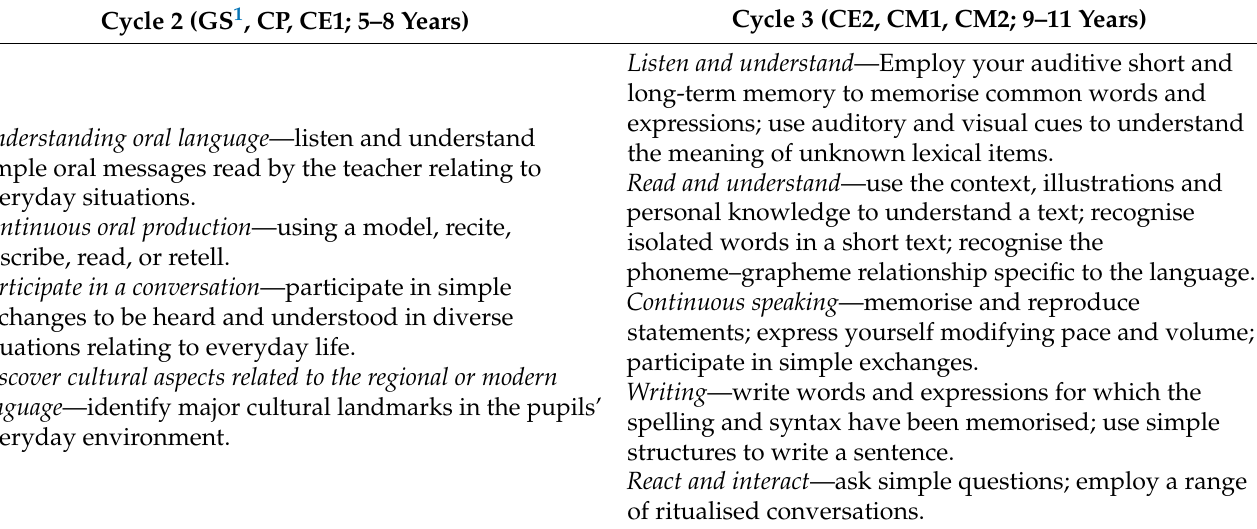
Table 1. MFL programme descriptors for younger and older primary learners in